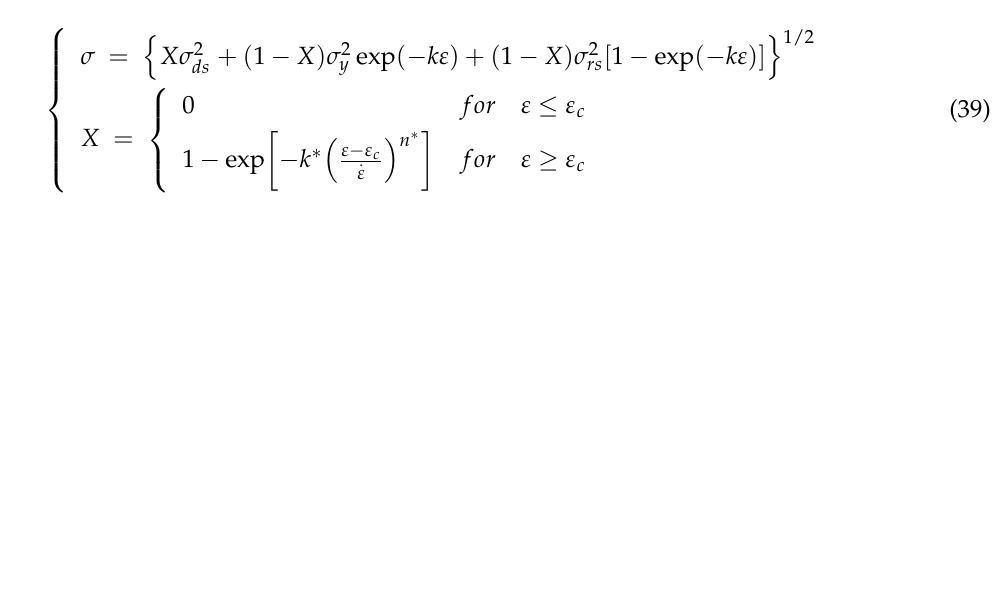
σ σ , rs and the Z parameter. The linear curves are